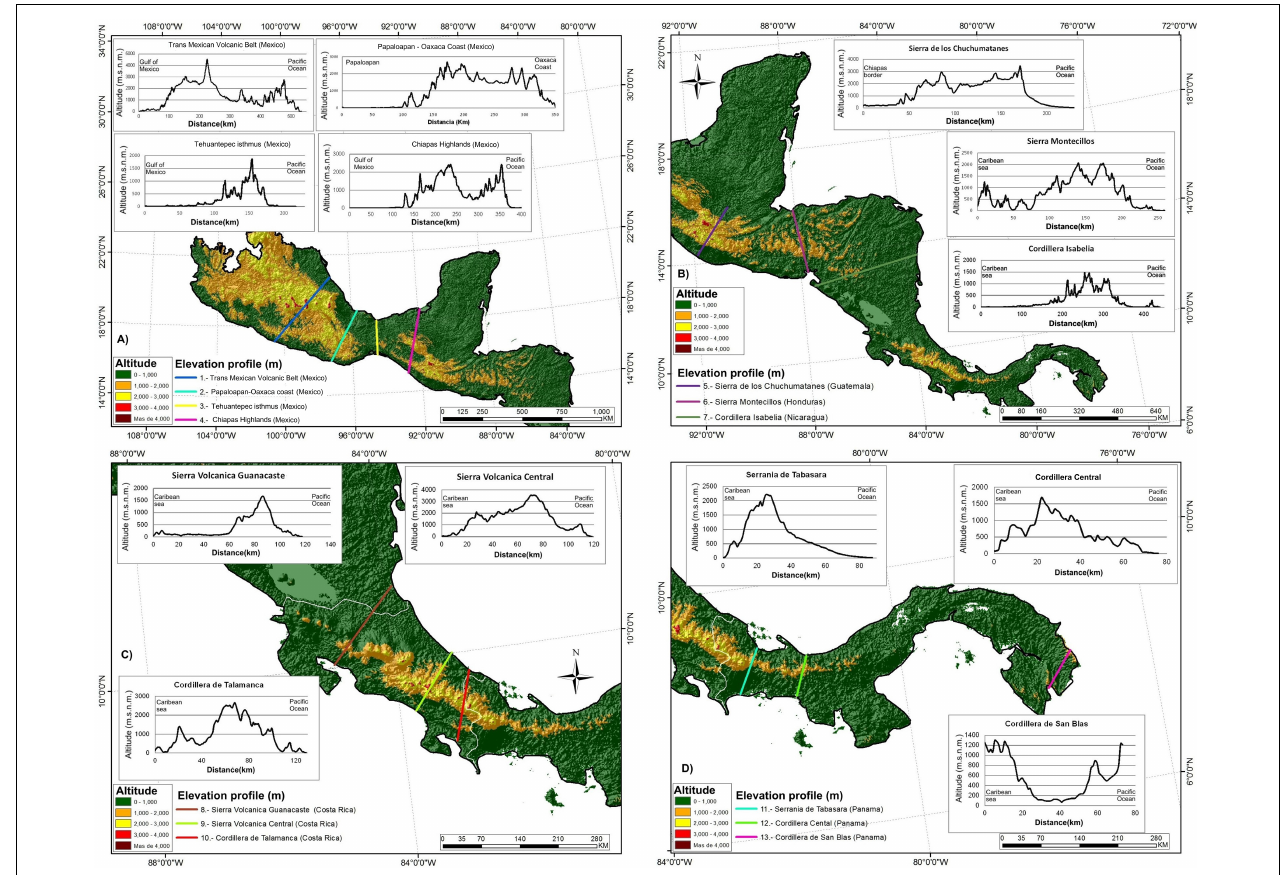
FIGURE 1 | Maps of the SMP with width and elevation profiles at selected points. The entire area was divided in four sections: (A) Mexico, (B) Guatemala, Honduras, Salvador, and Nicaragua, (C) Costa Rica, (D)